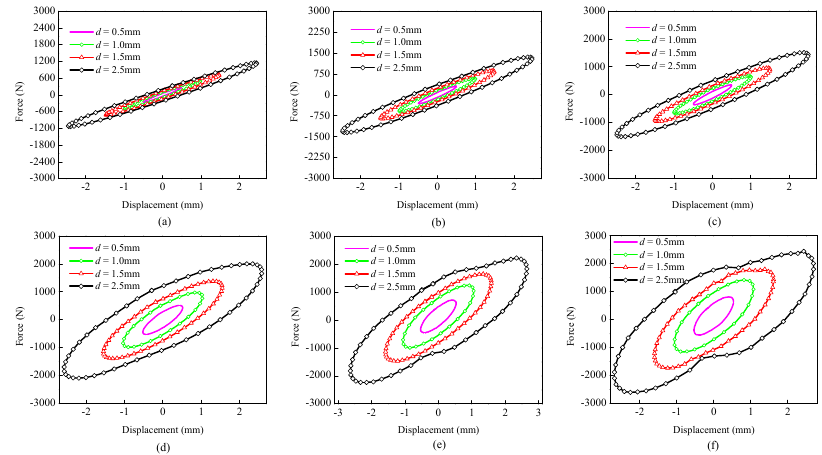
Figure 3. Hysteretic curves of the viscoelastic damper with changing displacement amplitudes. ( a ) f = 0.1 Hz. ( b ) f = 0.5 Hz. ( c ) f = 1 Hz. ( d ) f = 5 Hz. ( e ) f = 7 Hz. ( f ) f = 10 Hz. The force–displacement curves of the viscoelastic damper with different displacement amplitudes are given in Figure 3. The damping performance of the viscoelastic damper are significantly influenced by the displacement amplitudes. The maximum damping force, smoothness, and plumpness of the force–displacement curves are increased rapidly with increasing displacement amplitudes. However, the impacts of the displacement amplitudes on the major axis slopes of the force–displacement curves are not obvious, as the equivalent stiffness changes slightly when the displacement amplitude varies from 0.5 mm to 2.5 mm.